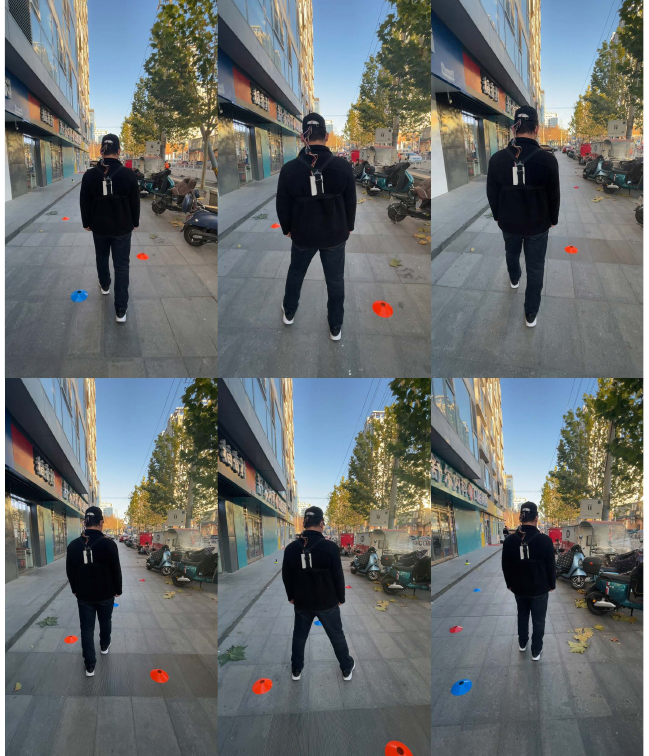
Figure 9. Walking obstacle avoidance experiment of visually impaired